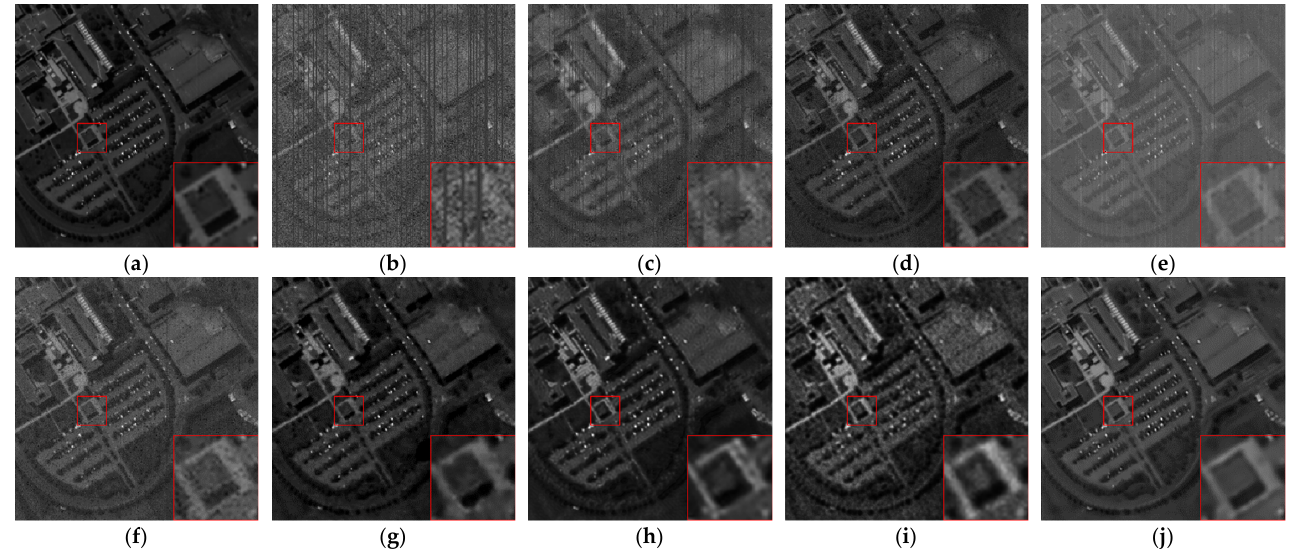
Figure 7. Case 4—Denoising results of different algorithms in band 19: ( a ) clean band; ( b ) noisy band; ( c ) BM4D; ( d ) LRMR; ( e ) HyRes; ( f ) L1HyMixDe; ( g ) DHP-2D; ( h ) SIP; ( i ) SURE-CNN; and ( j ) 3S-HSID.